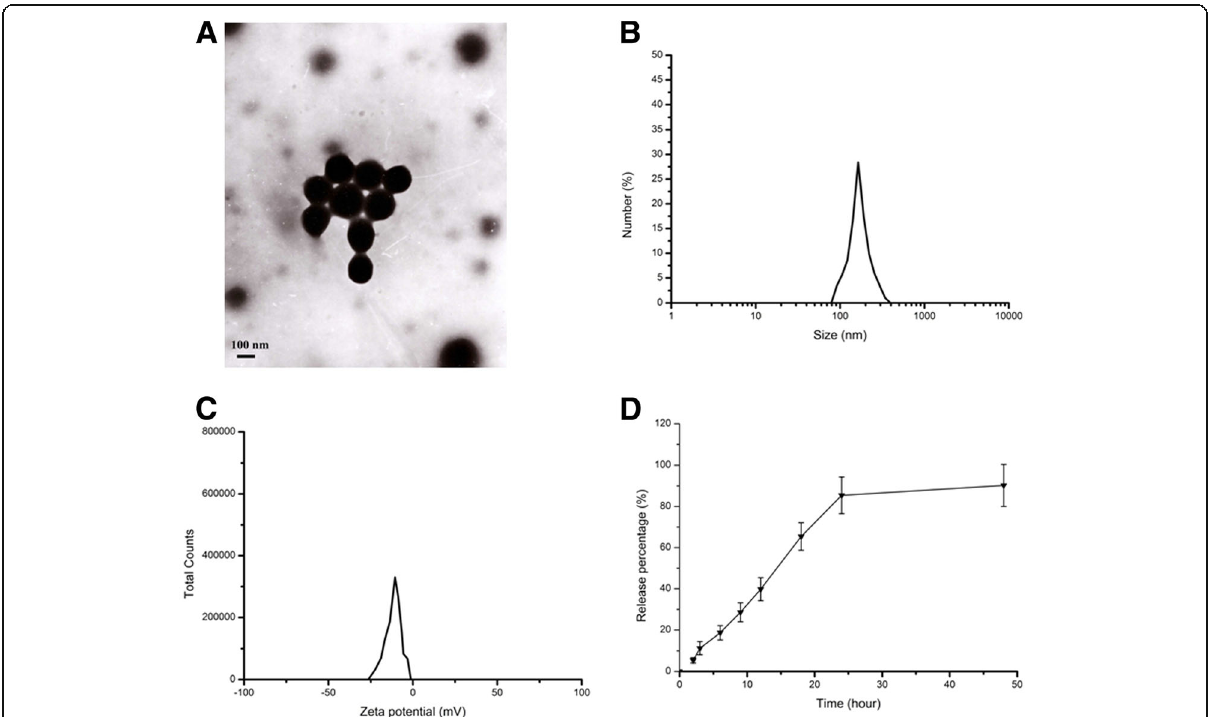
Fig. 1 Characterization of curcumin loaded CS-BSA NPs. a TEM image of curcumin loaded CS-BSA NPs. b Dynamic light scattering (DLS) analysis of the obtained curcumin loaded CS-BSA NPs. c Zeta potential analysis of the obtained curcumin loaded CS-BSA NPs. d The in vitro release profile of the obtained curcumin-loaded CS-BSA NPs in phosphate-buffered saline with a pH of 7.4 at 37 °C for 48